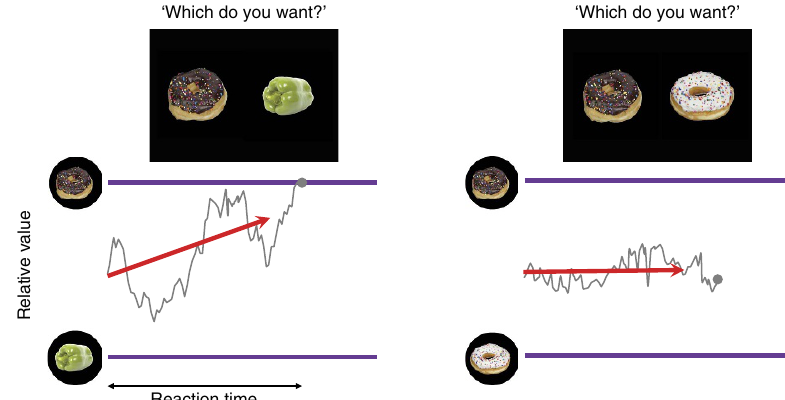
Figure 1 | DDMs for value-based decisions. The purple lines represent the decision boundaries. The red arrows indicate the mean drift rate. The grey fluctuating traces illustrate sample trajectories of a particle that drifts in the space of relative value between two given options. (left) If an option is preferred (that is, yields higher reward) than the other, the mean drift is biased toward the boundary of preferred option, making the particle to hit the decision boundary within a relatively short time. (right) However, if the given options are equally good, DDM assumes a mean drift without any bias, requiring much longer time for the particle to hit either decision boundary—even if both options are highly